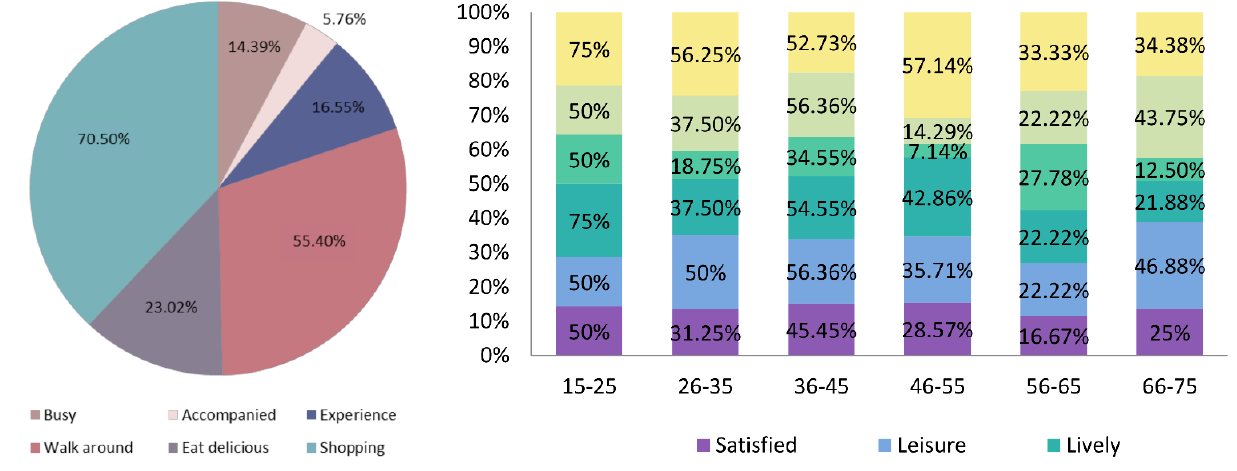
Figure 5. The description of the fair (Source: Author’s Analysis).